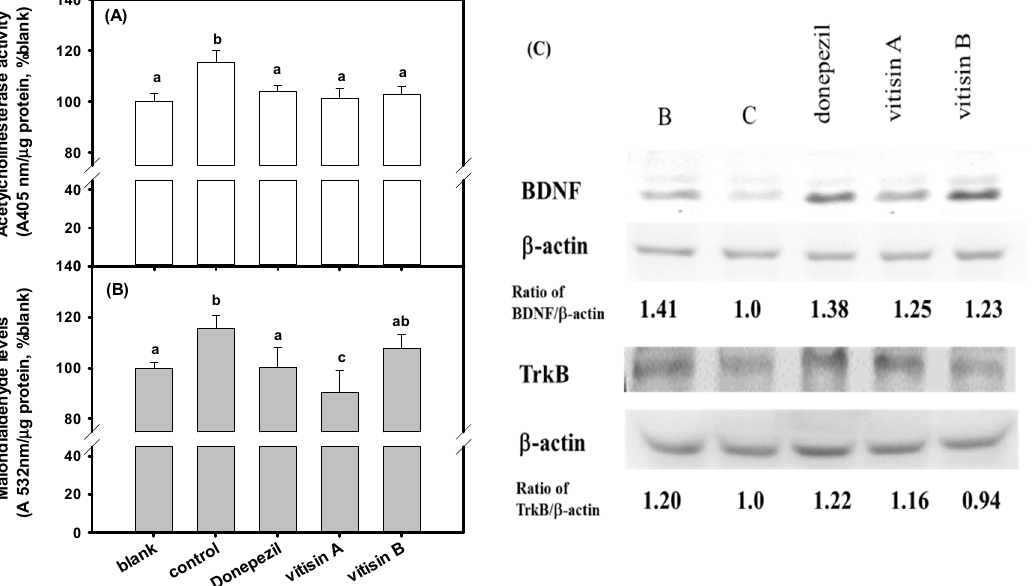
Figure 6. The changes of ( A ) AChE activity, ( B ) the MDA levels, and ( C ) BDNF and TrkB protein expressions, and expressed as ratios of BDNF/ β -actin and TrkB/ β -actin in the brain tissue extracts of amnesiac mice after vitisin A or vitisin B treatments (40 mg/kg). The scopolamine-injected mice without any sample treatments were used as the control. Data were expressed as mean ± SD of three independent quantitative experiments. The one-way analysis of variance (ANOVA) and the post hoc Tukey’s test were used to compare the differences among multiple groups. It was considered as the significant difference ( p < 0.05) among groups which marked the different lowercase letters.